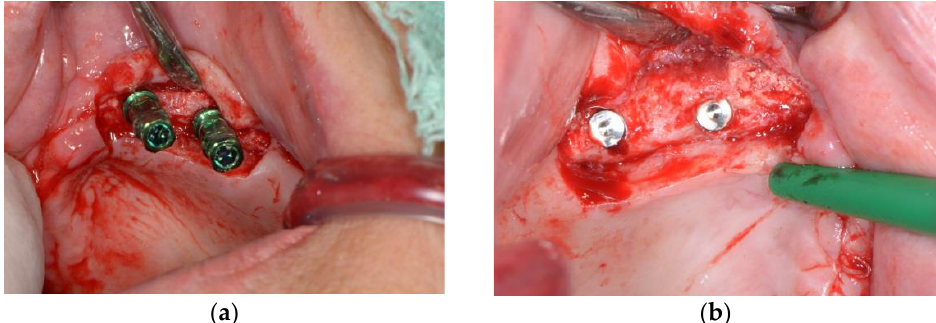
Figure 5. ( a ) Implant placement with transfer on left side of maxilla; ( b ) Implant placement with cover screw on right side of maxilla.